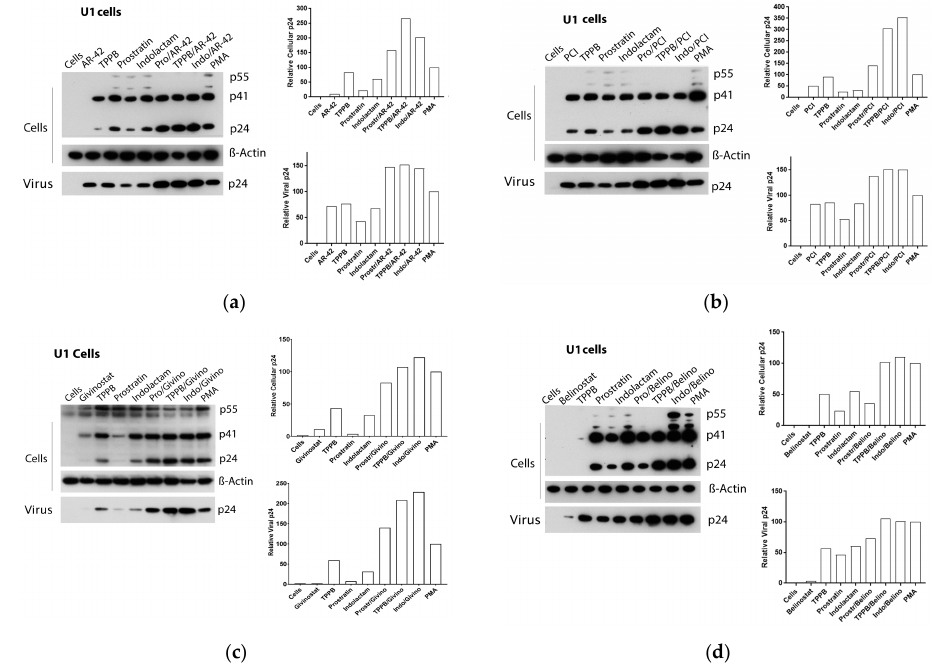
Figure 7. Effect of combinations of LRAs on the reactivation of latent HIV in U1 cells. Immunoblot analysis of cell lysates and viral lysates and related densitometry analysis. β -Actin was used as a loading control. The densitometry analysis of the cell-associated Gag p24 is relative to β -actin and expressed as a percentage of the positive control PMA set to 100. The densitometry analysis of the virion-associated Gag p24 is relative to the untreated control cells and expressed as a percentage of the positive control PMA set to 100. Immunoblots are representative of two independent experiments. A